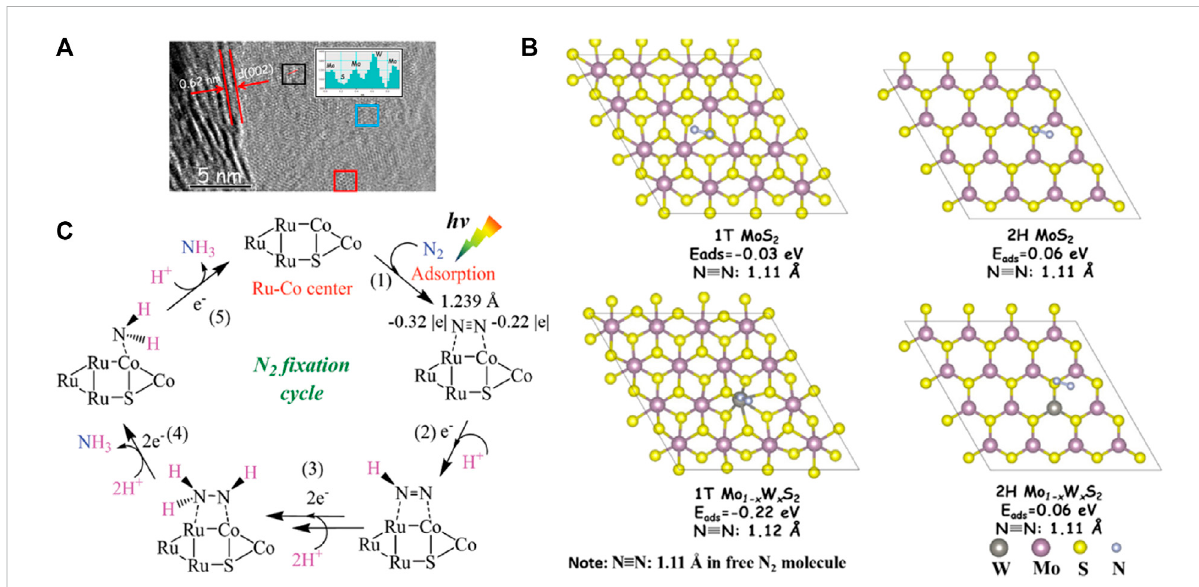
FIGURE 11 (A) HRTEM image of MWS-2 nanosheets. The red and blue squares represent the 2H and 1T structures, respectively; (B) Different adsorption energiesofN 2 moleculeson1TMoS 2 ,1TMo 1 − x W x S 2 ,2HMoS 2 ,and2HMo 1 − x W x S 2 .ReproducedfromQinetal.(2021)withpermissionfromAmerican ChemicalSociety. (C) ProposedNRRreactionschemesonRu-SV-CoS/CN.ReproducedfromYuanetal.(2020)withpermissionfromtheJohnWiley and